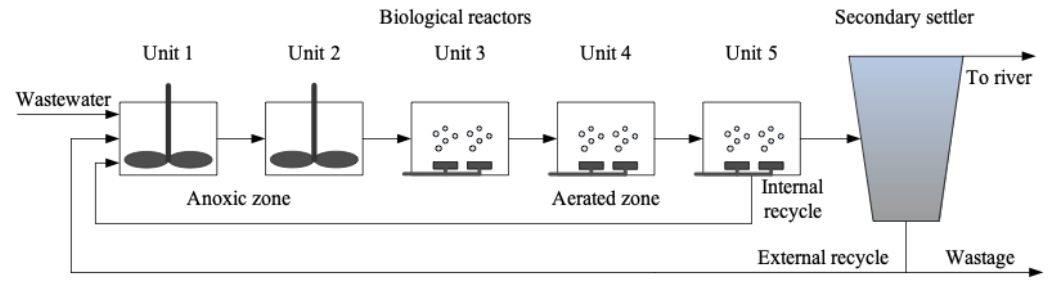
Figure 2. Schematic representation of the benchmark simulation model No. 1 (BSM1).